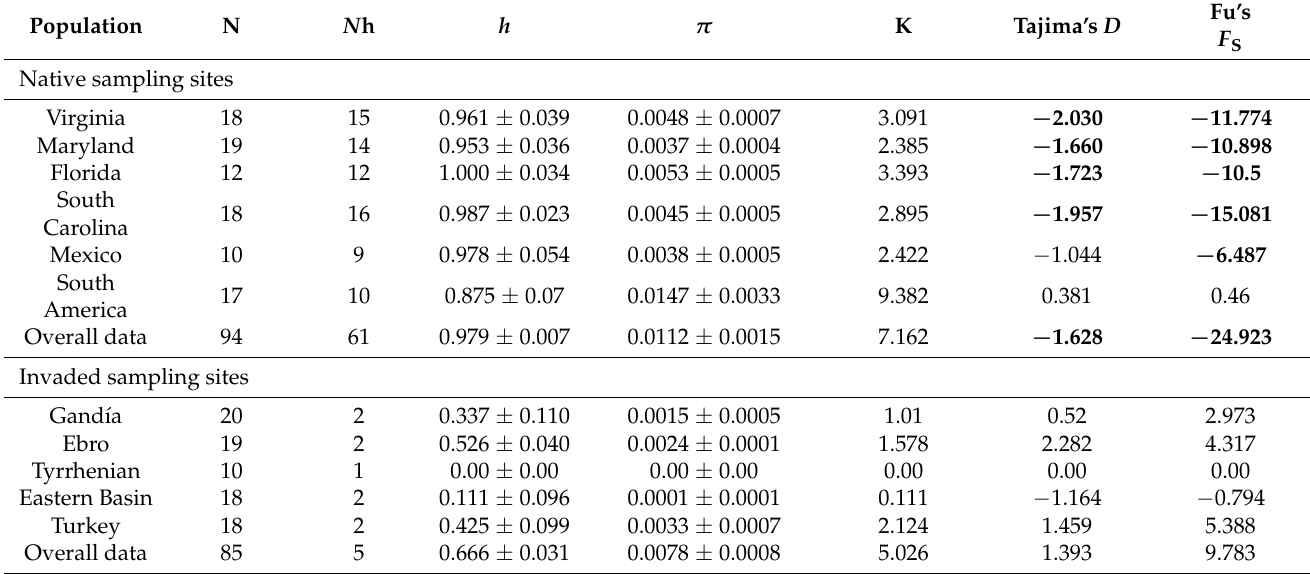
Table 4. Genetic diversity and demographic estimates for populations of the blue crab Callinectes sapidus from native and invaded sampling sites, based on the analysis of 637 basepairs of the mitochondrial COI gene. Values reported for each population as well as for each regional dataset are: sample size (N), number of haplotypes ( N h), haplotype diversity ( h ), nucleotide diversity ( π ), mean number of nucleotide differences (K), Tajima’s D test, and Fu’s F S test. Significant values of the analyzed neutrality tests (Tajima’s D , and Fu’s F S ) are indicated in bold. N h h π K Tajima’s D